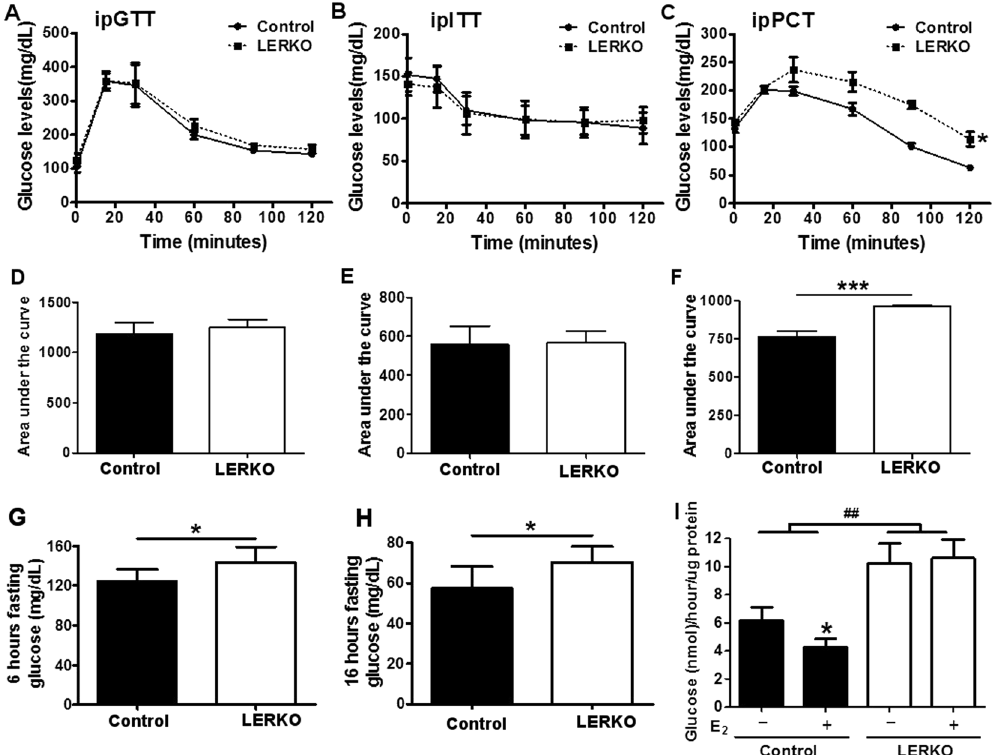
Figure 2. Glucose, insulin and pyruvate tolerance tests. ( A ) Glucose tolerance test (GTT) was performed on Control (circle symbols) and LERKO (square symbols) mice. Glucose (2 g/kg body weight) was administrated by intraperitoneal injection after overnight fasting. ( D ) Area under the curve of the GTT displayed in ( A ). ( B ) Insulin tolerance test (ITT) was performed on Control (circle symbols) and LERKO (square symbols) mice. Insulin (0.3 U/kg body weight) was administrated by intraperitoneal injection after 7 hours fasting. ( E ) Area under the curve of the ITT displayed in ( B ). ( C ) Pyruvate challenge test (PCT) was performed on Control (circle symbols) and LERKO (square symbols) mice. Pyruvate (2 g/kg body weight) was administrated by intraperitoneal injection after 6 hours fasting. ( F ) Area under the curve of the PCT displayed in ( C ). * p < 0.05 versus Control. ( G – H ) 6 hours and 16 hours fasting glucose of Control and LERKO mice. * p < 0.05, *** p < 0.001 versus Control (Fig. 2A–H). ( I ) Glucose production assays were conducted in primary hepatocytes from Control and LERKO mice; cells were subjected to 4 hours of serum starvation before the addition of E 2 for 12 hours. The experiments were performed 1–3 weeks after virus injection. The data are expressed as the means ± SD, * p < 0.05, vehicle versus E 2 treatment, ## p < 0.01 Control versus LERKO (Fig.